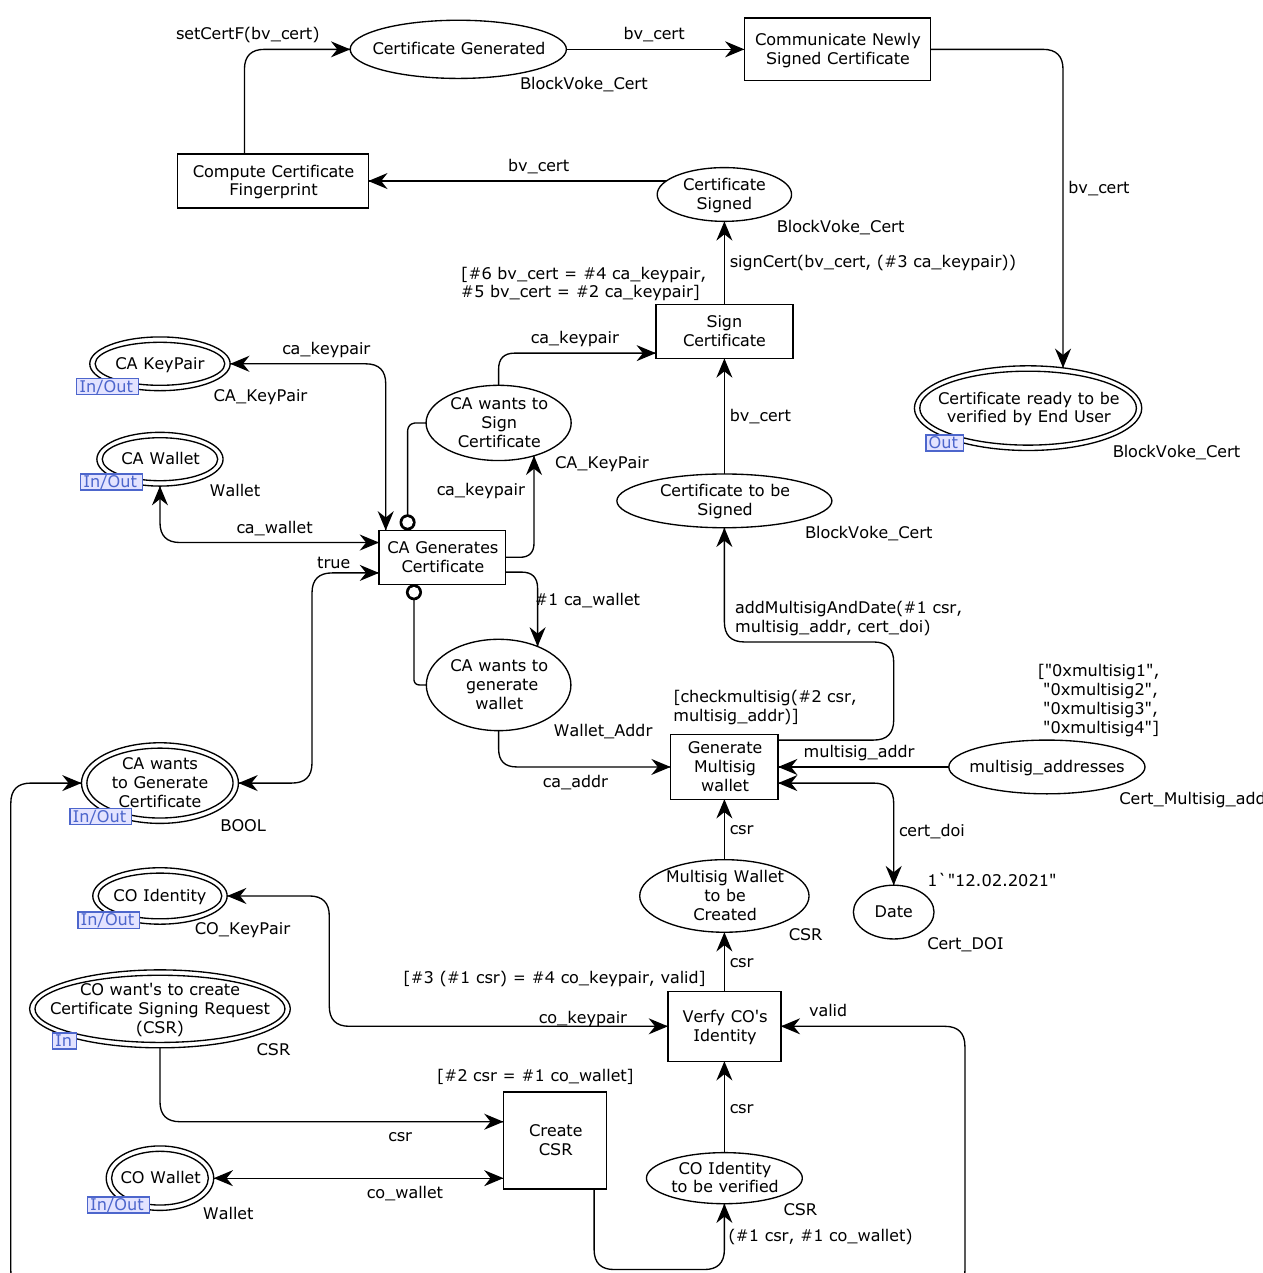
Figure 8. ‘Generate Certificate‘ sub-module of the BlockVoke CPN